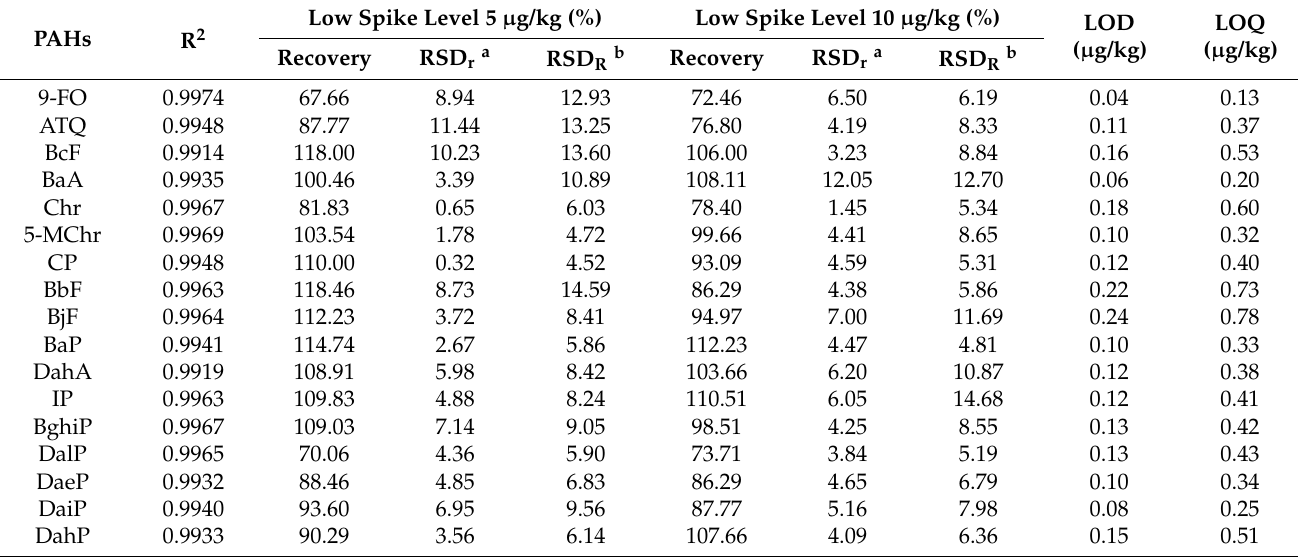
Table 2. Validation results of the established UPCC-QqQ-MS